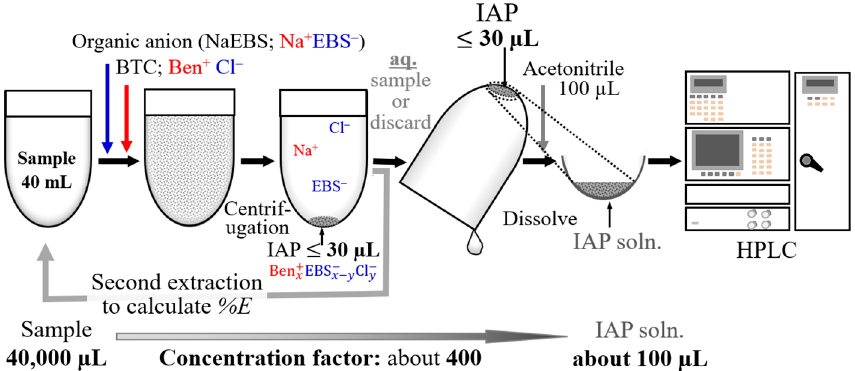
Figure 1. Schematic representation of the microextraction of an IAP formed in situ from the aqueous phase by adding BTC and NaEBS.